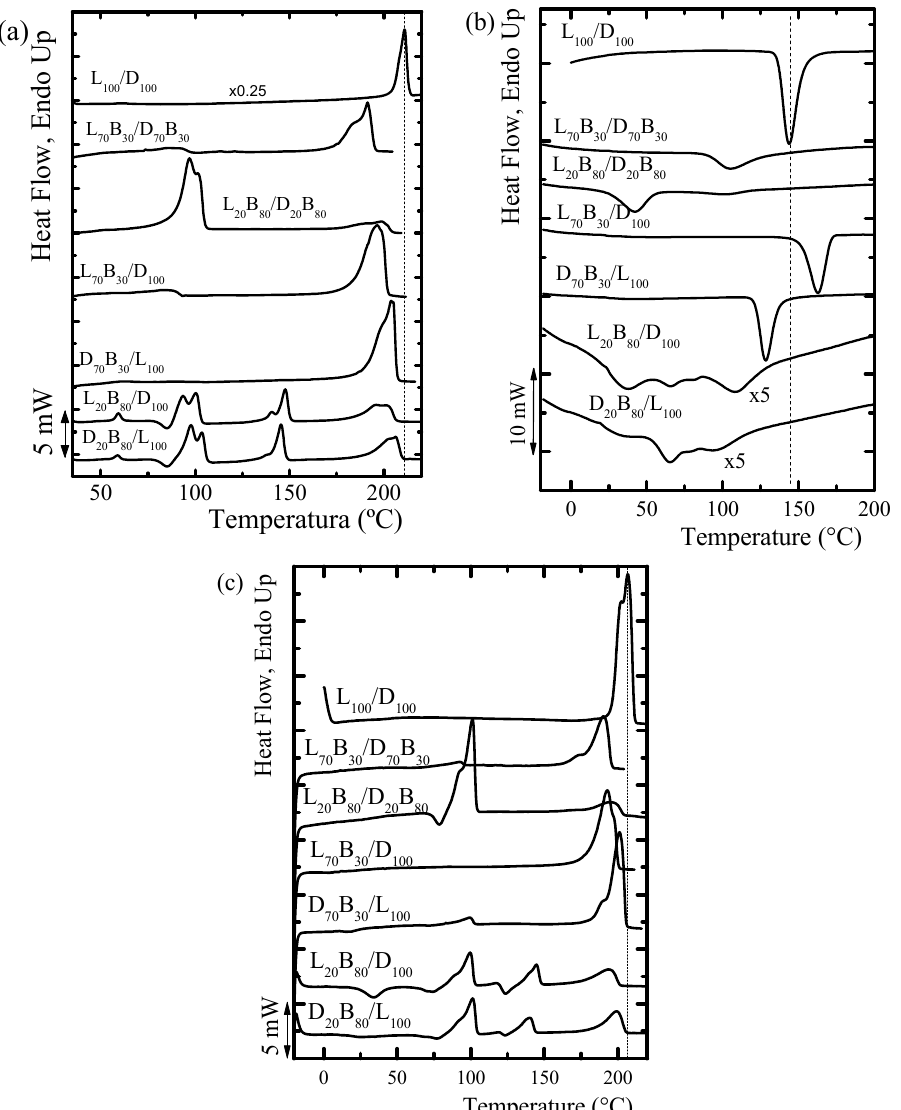
Figure 6. Non-isothermal DSC ( a ) first heating, ( b ) cooling, and ( c ) second heating scans at 20 °C/min for the indicated stereocomplexes. The dashed line represents the peak crystallization and melting temperature for the L 100 /D 100 stereocomplex.